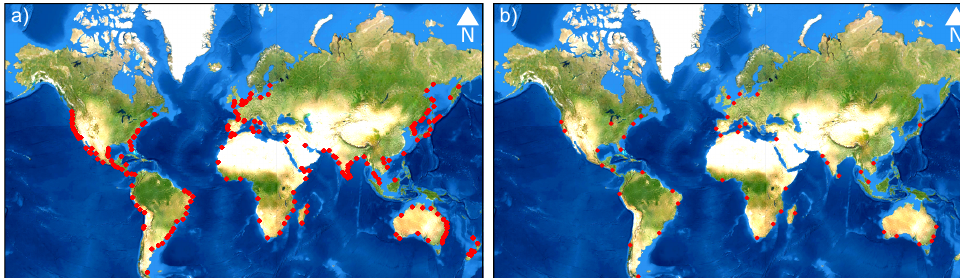
Figure 1. ( a ) Location of the manually labeled points used for the calibration and the first validation of the classification algorithm (red dots). ( b ) Location of the fifty selected areas of interest for the second validation of the algorithm (red